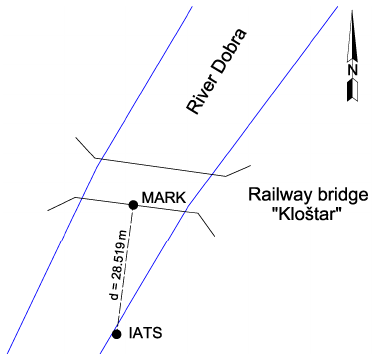
Figure 13. IATS prototype setup in the field in relation to the bridge.